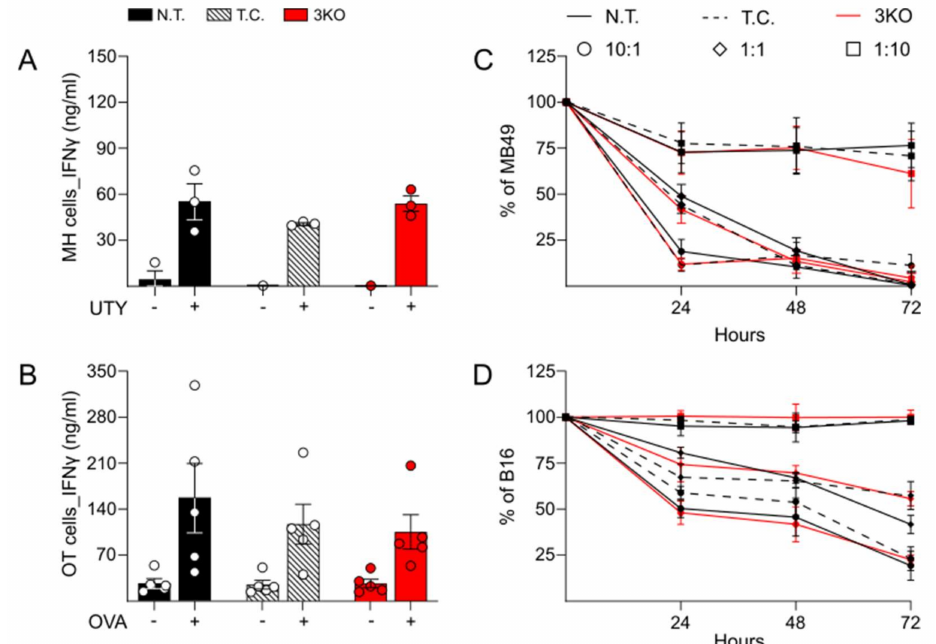
Figure 2. Immune activity and cytotoxicity in CRISPR/Cas9-edited MH and OT-1 CD8 + T cells. ( A ) ELISA quantification of IFN γ production after 72 h in presence or absence of UTY peptide. Bars are representative of three independent experiments with MH CD8 + T cells derived from three different animals. ( B ) ELISA quantification of IFN γ production induced by 72 h stimulation with OVA